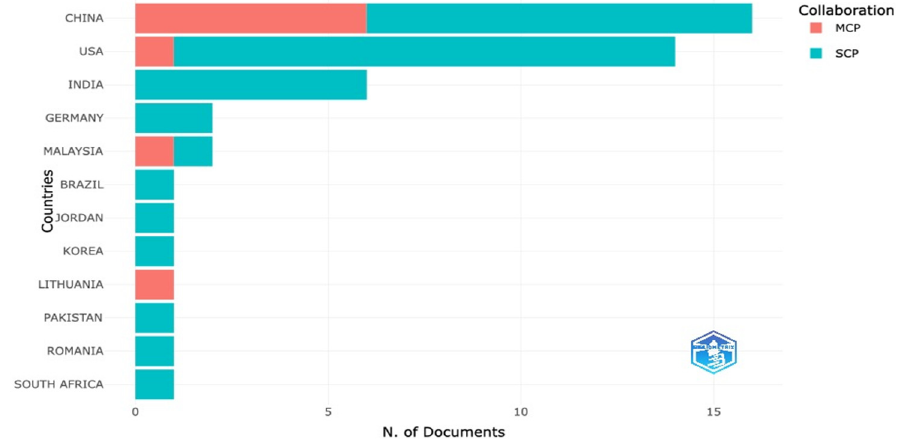
Figure 6. Corresponding author’s country.